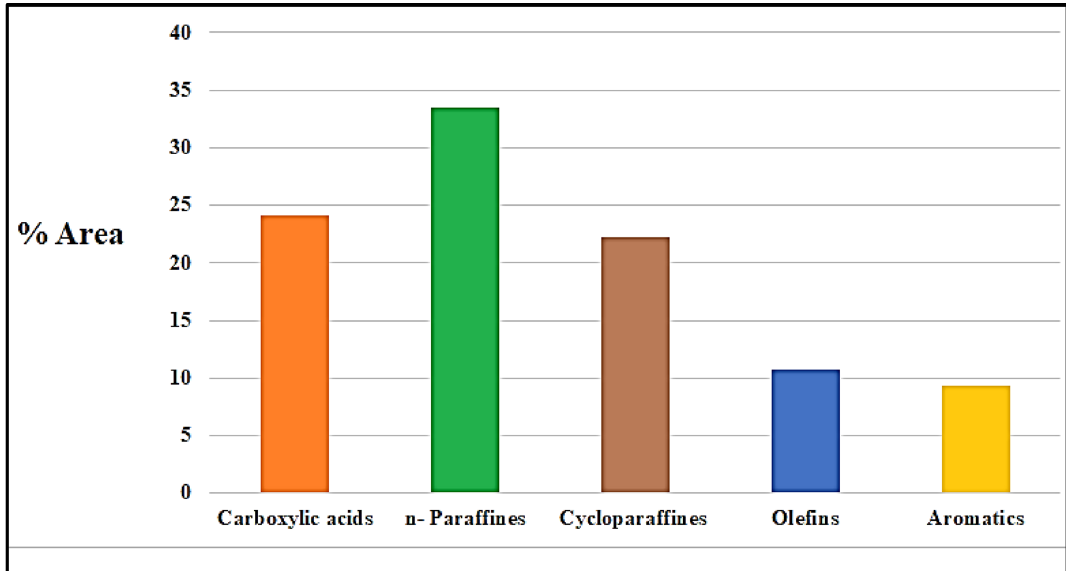
Figure 11. Liquid Product Composition of a Selected Sample. (Temp. 400 °C, 50 bar, LHSV: 1 h -1